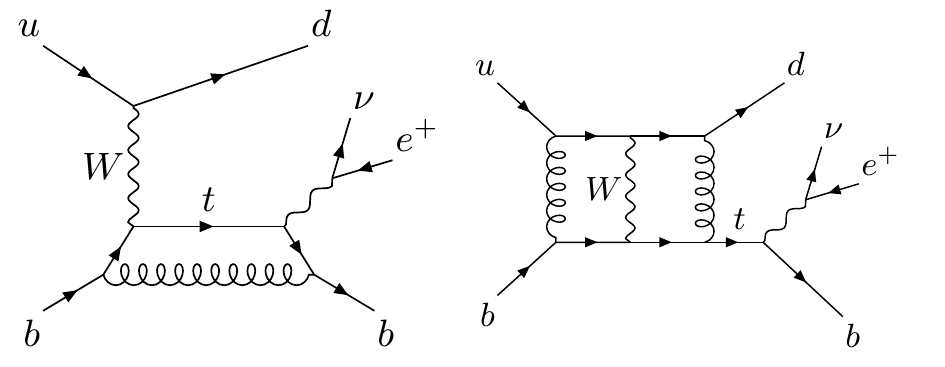
Figure 2 . Example Feynman diagrams for one-loop off-shell contributions (left) and color- suppressed interference contributions (right) in t -channel